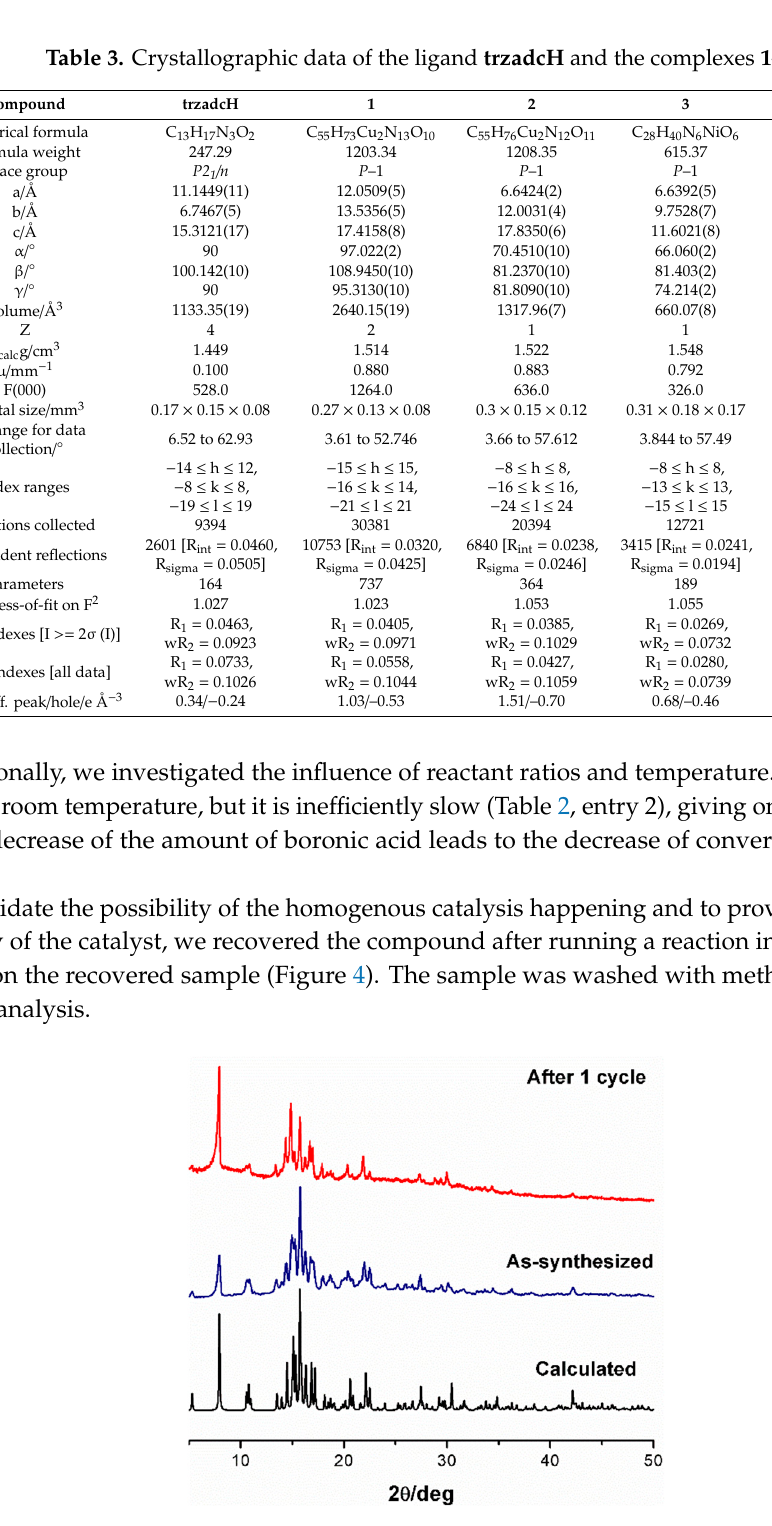
Figure 4. PXRD of the compound 2 before and after running the reaction.